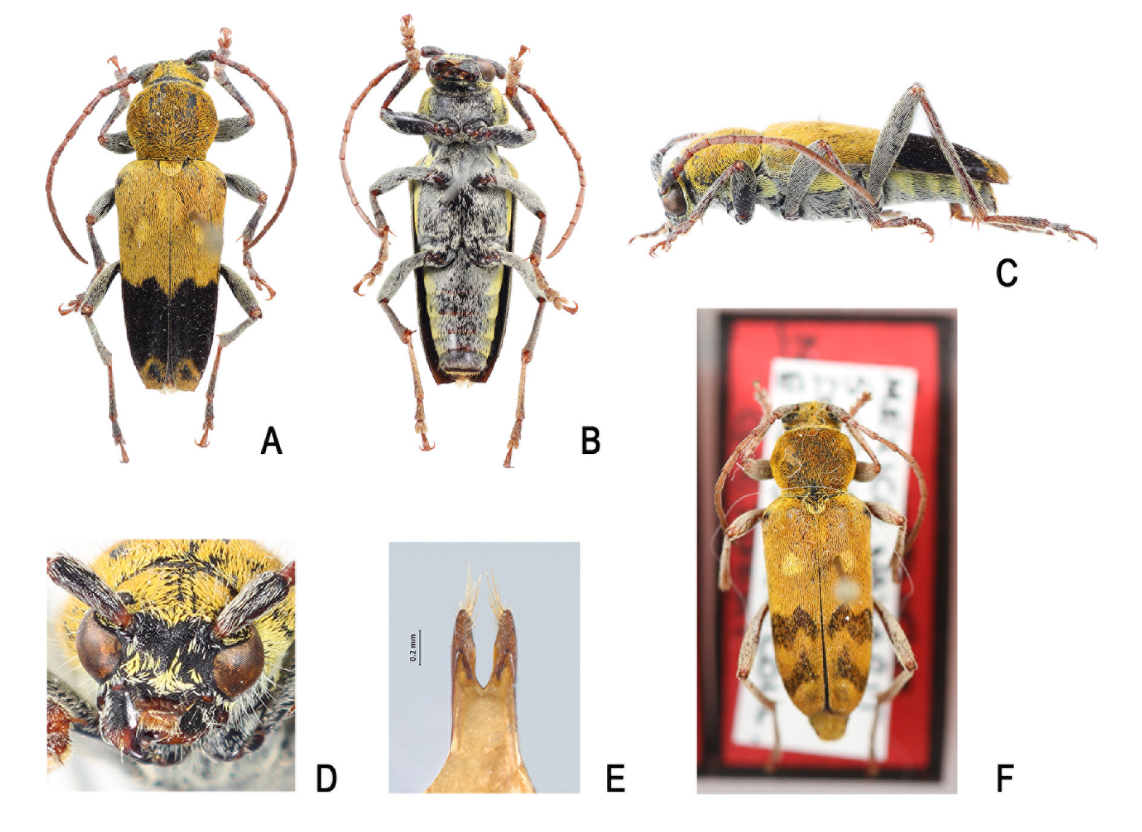
Fig. 2. Ochraethes nigroapicalis sp. nov. A – D . Holotype, ♂ (EMEC). A . Habitus, dorsal. B . Habitus, ventral. C . Habitus, lateral. D . Frons. E . Paratype, ♂ (CNIN), ventral view of male genitalia. F . Paratype, ♀ (EMEC), habitus,